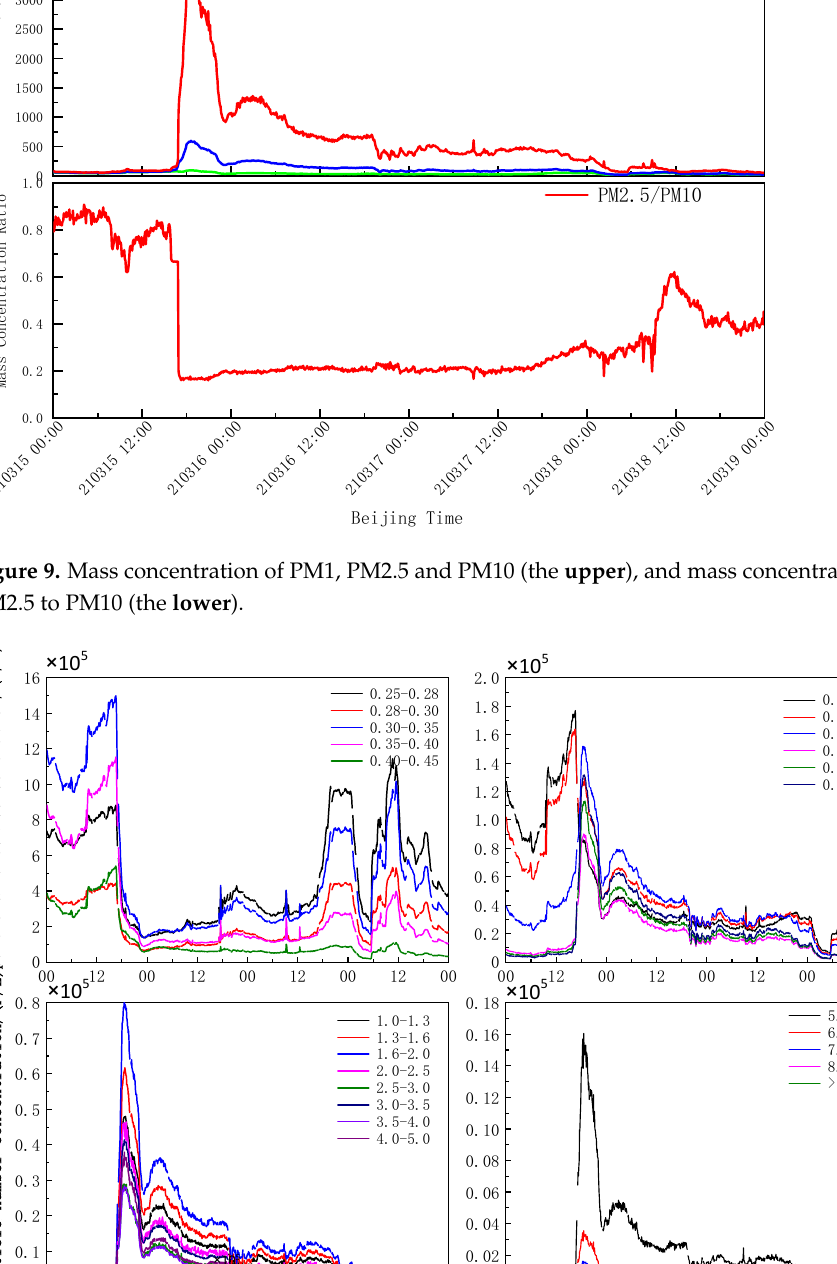
4.63 × 10 8 Figure 11. Particle proportion of different size intervals, varying with